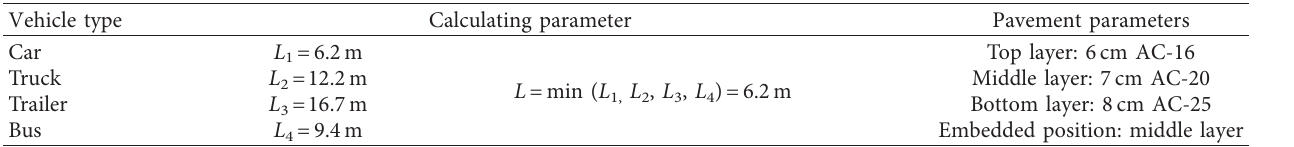
Figure 8: Test Scheme for disturbance characteristics of ISA. Table 5: Test results of driving perception performance of